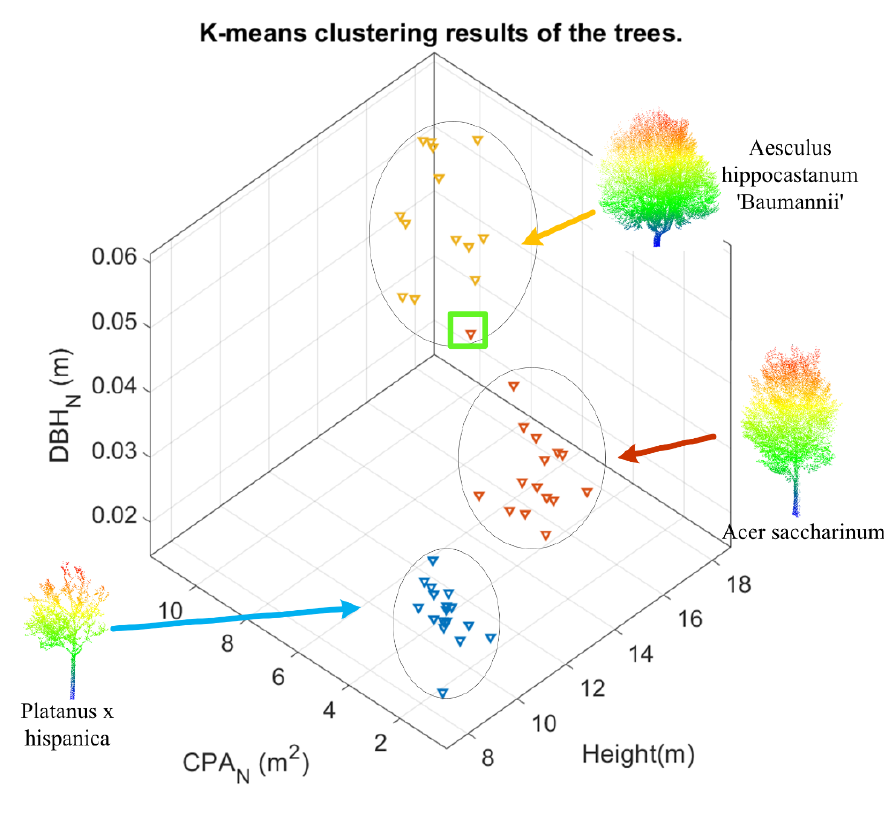
Figure 8: Automatic k-means unsupervised classification of trees, using normalized tree